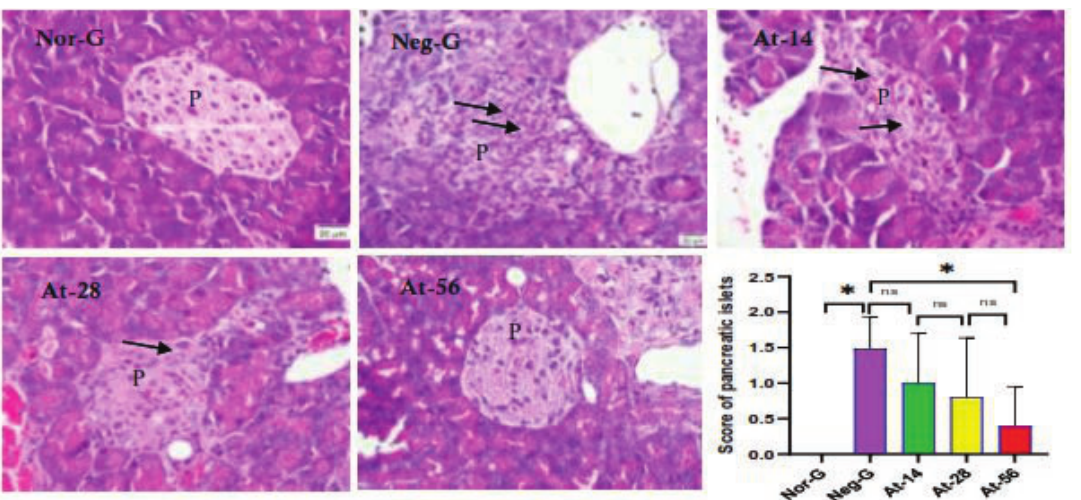
Figure 1. Histological feature of Pancreatic islets injury following antlion treatment in each group. Microscopic investigation of pancreas from normal control group (Nor-G) showed the normal appearance of pancreatic islets, lightly stained than the surrounding acinar cells. Pancreas from the Neg-G mice showed collapsed islet architecture and tissue damage. Severe mononuclear cell infiltration were also found. On the other hand, histological images from At-14, At-28, and At-56 showed alleviation in the tissue damage and reduction mononuclear cell infiltration gradually. The lowest pancreatic islet damage was found in At-56, showing almost no tissue damage and infiltration. P: pancreatic islet. Mann Withney test: * p<0.05; ns: not